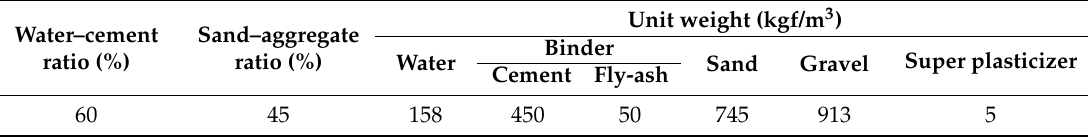
Table 9. Material test results for epoxy.